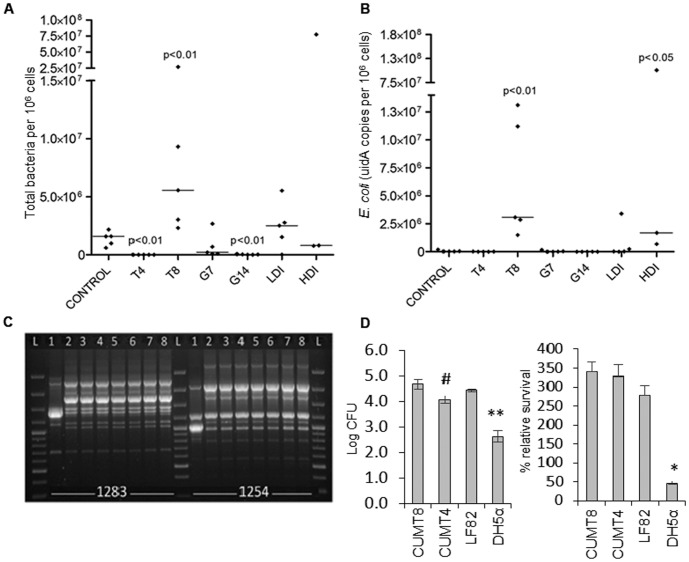
Ileitis-induced dysbiosis is associated with increased bacteria and clonal proliferation of adherent invasive E. coli (AIEC).(a) Total bacteria quantified by real-time PCR, expressed as bacterial CFU per 106 murine cells. Moderate to severe ileitis in T8 is associated with increased bacteria relative to controls. Mild pathology (T4, G14) induces a decrease. (b) Moderate to severe ileitis (T8, HDI) induces E. coli proliferation (E. coli uidA quantification by real-time PCR). (c) Agarose gel electrophoresis showing the products of Random Amplification of Polymorphic DNA (RAPD-PCR) using primers 1283 and 1254. E. coli strains from: T4 (Lanes 1–3), T8 (4, 5) and HDI (6–8). Lane L, 100bp plus DNA ladder. E. coli isolates in lanes 2–8 are clonal, and a representative strain was designated CUMT8. E. coli in lane 1 was designated CUMT4. (d). Invasion and survival of E. coli CUMT8 and CUMT4 in cultured epithelial cells (Caco-2) and macrophages (J774). CUMT8 and CUMT4 invade, and persist intracellularly like CD-associated AIEC LF82, and better than commensal E. coli DH5α (* = P<0.01, ** = P<0.001 vs other strains). CUMT4 was less invasive than CUMT8 (# =  P<0.01).